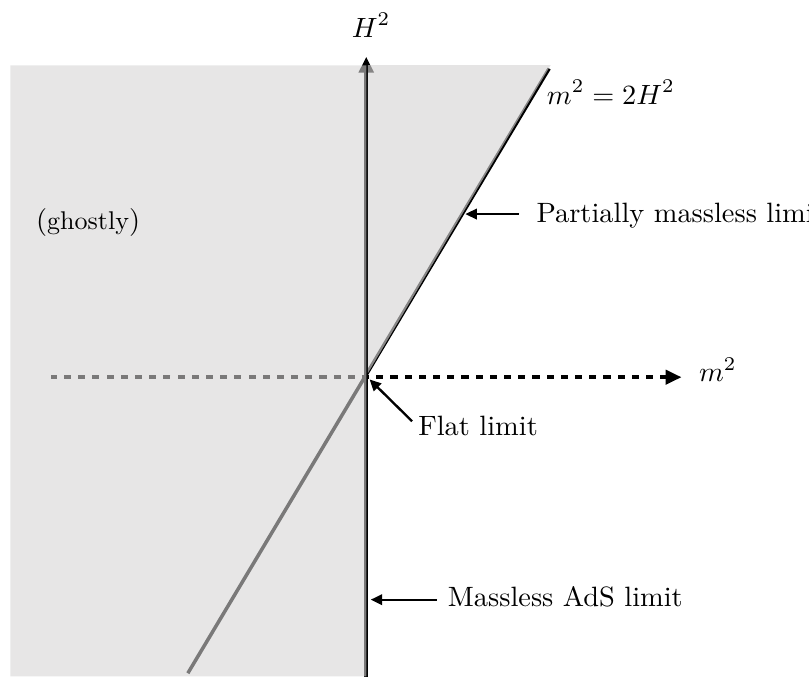
Figure 1 . Linear spin-2 on maximally symmetric spaces and its various